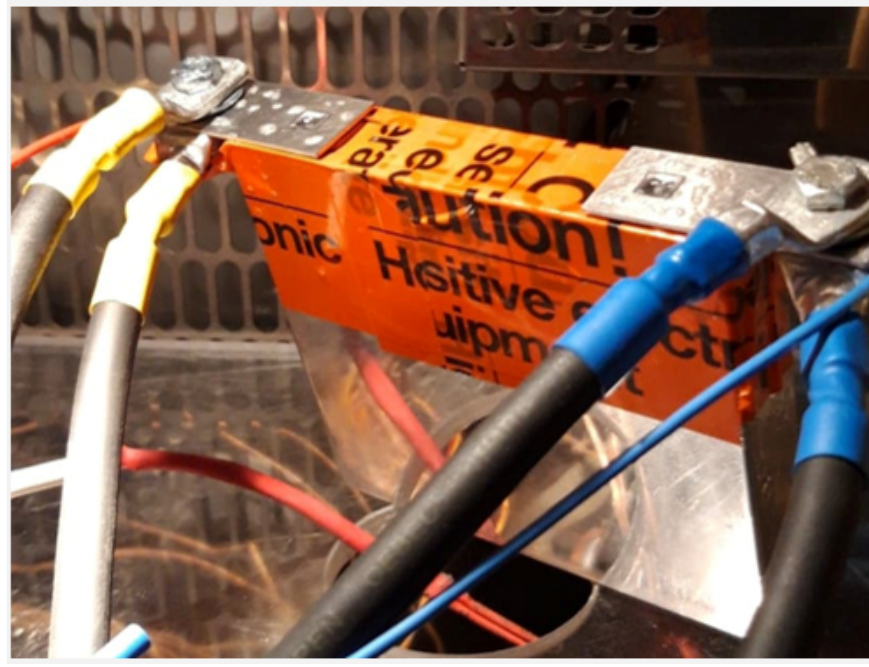
Figure 1. Studied LTO